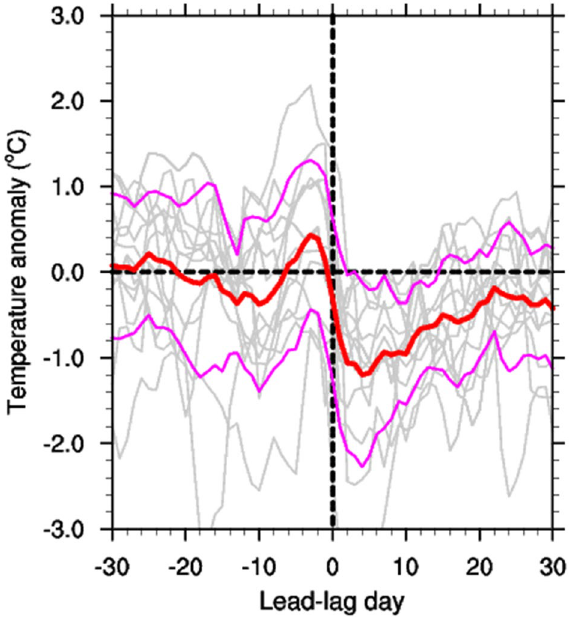
Figure 2. Lead-lag temperature anomaly when typhoons were located at 30°N. The red line shows the average of 12 typhoons, the magenta lines denote ± 1 standard deviation, and gray lines represent individual typhoons. Day 0 denotes typhoon arrival